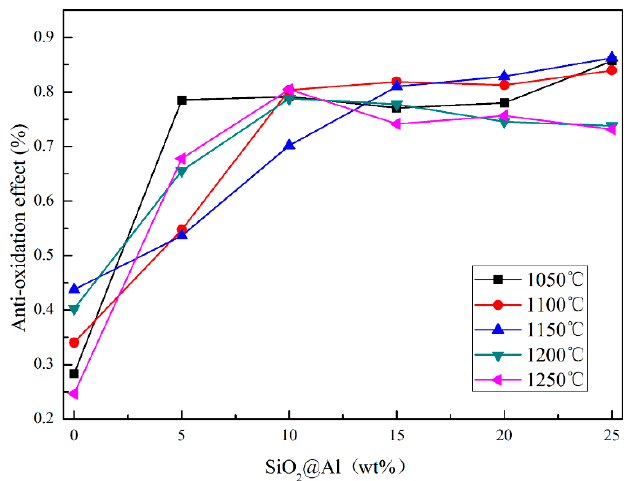
Figure 3. Anti-oxidation performances of the coatings with different proportion of SiO 2 @Al. The non-isothermal kinetic for sample protected by ASMA, sample protected by AS, and bare sample are shown in Figure 4. The apparent activation energy, ( E a ), was calculated by the Arrhenius equation. As shown in Equation (6), if the concentration of reactant ( B ) was constant, the reaction rate ( v ) would have a positive correlation with the reaction rate constants (k), which is the function of temperature described by Equation (7) (Arrhenius equation).